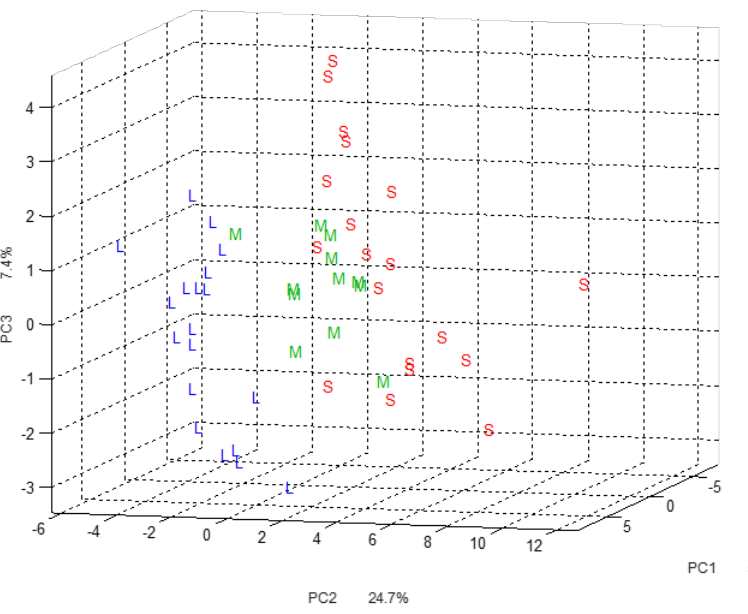
Figure 6. Multivariate data analysis of FT-IR data using the principal component analysis (PCA). L: leaf-derived lignin. M: mixture-derived lignin. S: stem-derived lignin.